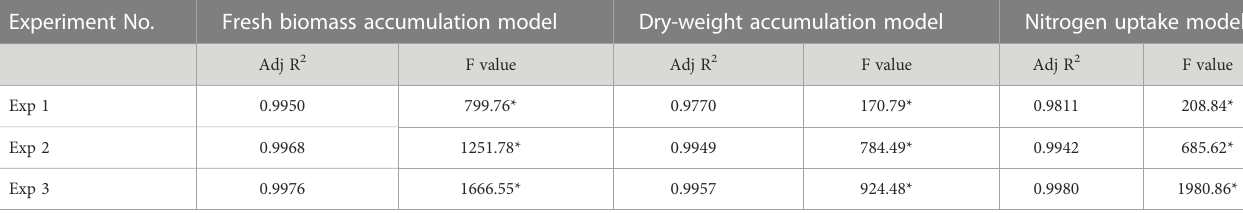
*represents the signi fi cant difference at ≤